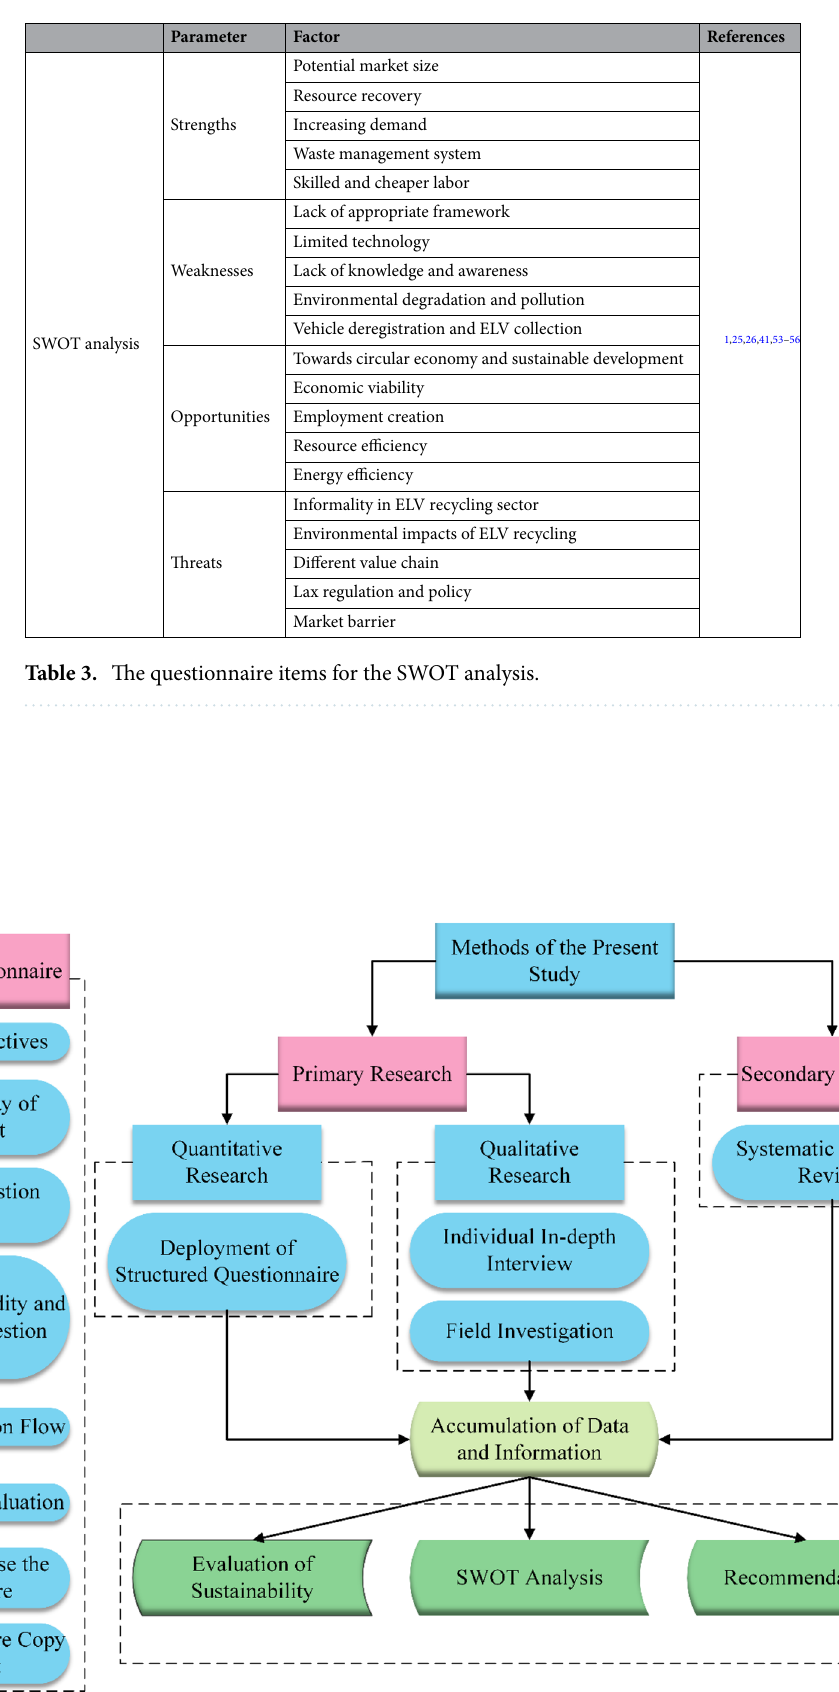
Figure 4. Methodology integrating structured questionnaire, primary research, and secondary